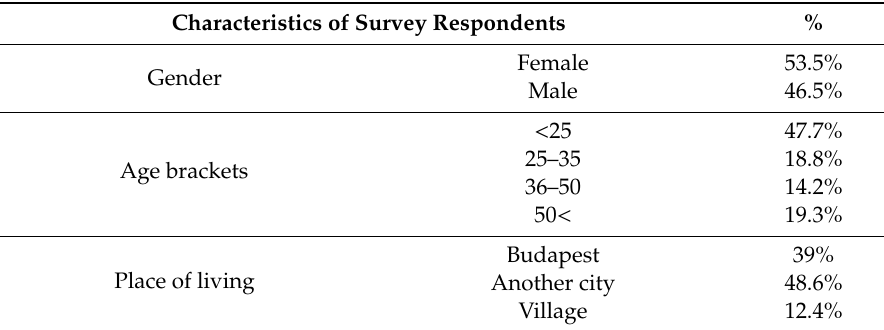
Table 1. Grouping of respondents based on variables ( n =